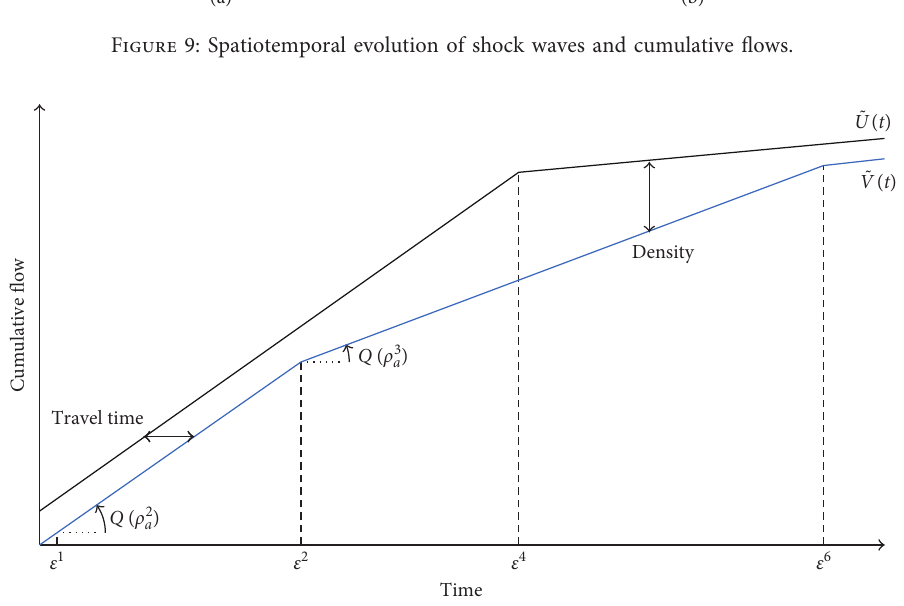
Figure 10: Cumulative inflow and outflow